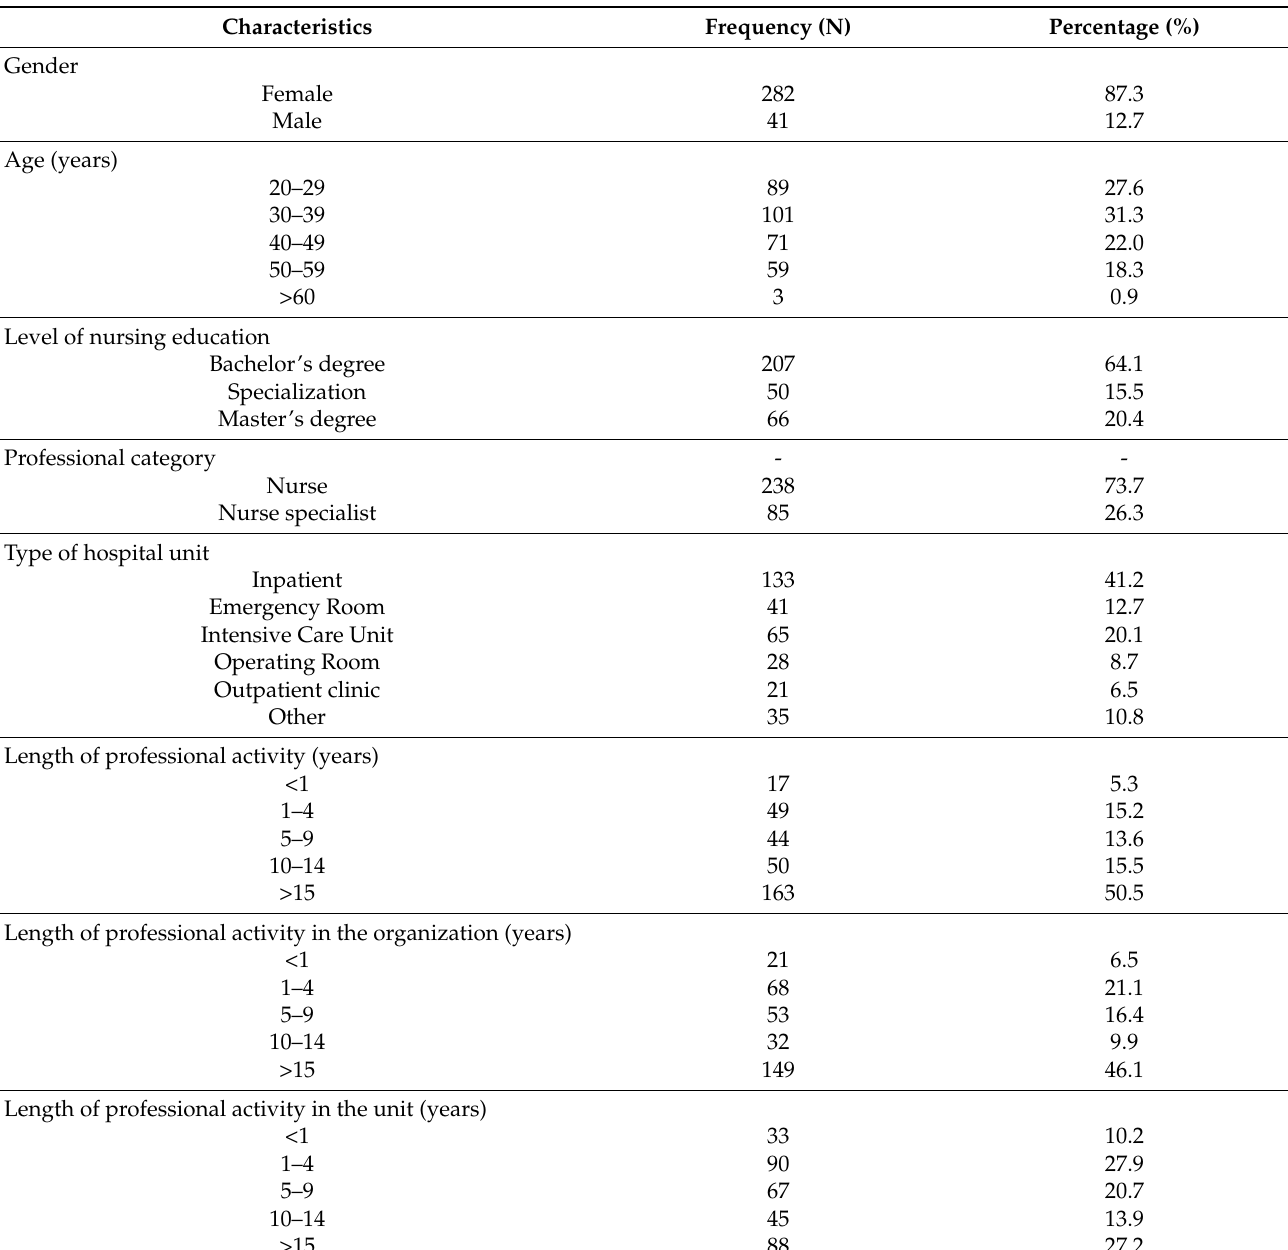
Table 1. Sociodemographic, academic and professional